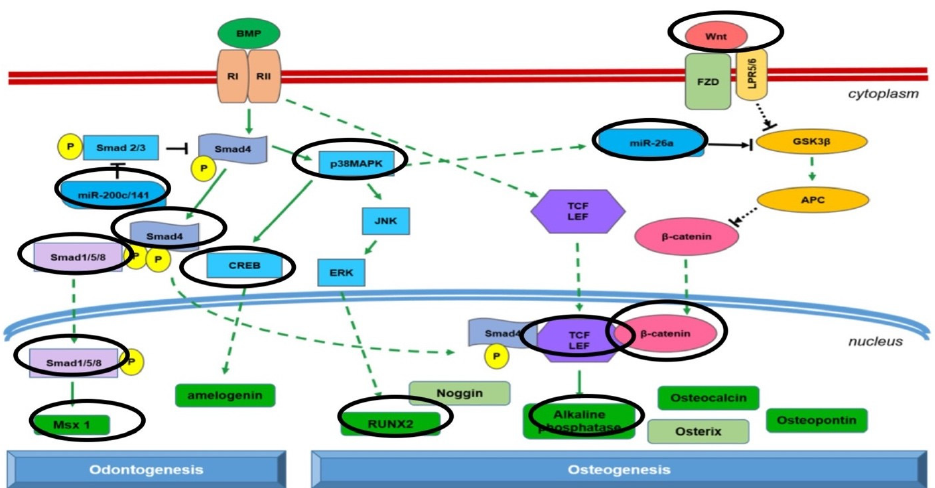
Figure 9. Pathways expressed in DPSCs cultured on dentin surfaces. DPSCs cultured on DP gave rise to the production of a harder ECM than that obtained from xenogenic bone grafts. This greater external mechanoinduction acts on the commitment of stem cells, stimulating both the osteogenic pathway (by means of WNT signaling with the expression of miRNA 26a), and odontogenic phenotyping (thanks to miRNA 200 and SMAD1). Modified from Zhang et al. [61].